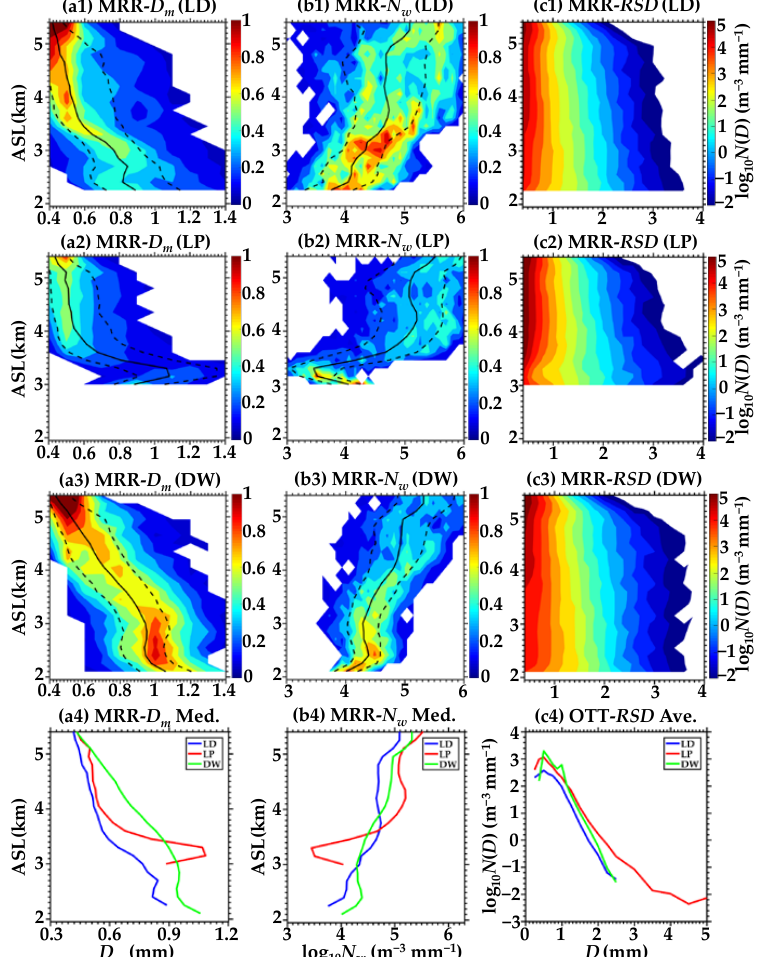
Figure 6. NCFADs of the mass-weighted mean diameter D m (mm) and the logarithm of the generalized intercept parameter log 10 N w (m −3 mm −1 ) for the cumulus mixed cloud and precipitation stage over the ( a1 , b1 ) LD, ( a2 , b2 ) LP, and ( a3 , b3 ) DW sites. Contours represent occurrence. The black dashed lines represent the 25th, 50th, and 75th percentiles. Subfigures ( a4 , b4 ) are the median profiles of D m and log 10 N w over three sites. Vertical distribution of raindrop size distribution RSDs for the cumulus mixed cloud and precipitation stage over ( c1 ) LD, ( c2 ) LP, and ( c3 ) DW. Contours represent log 10 N(D) (m − 3 mm − 1 ), and ( c4 ) is averaged RSDs on the ground at LD, LP, and DW. From 4.0 to 3.3 km over LP, Ns of small raindrops ( D < 1 mm) suddenly decrease,